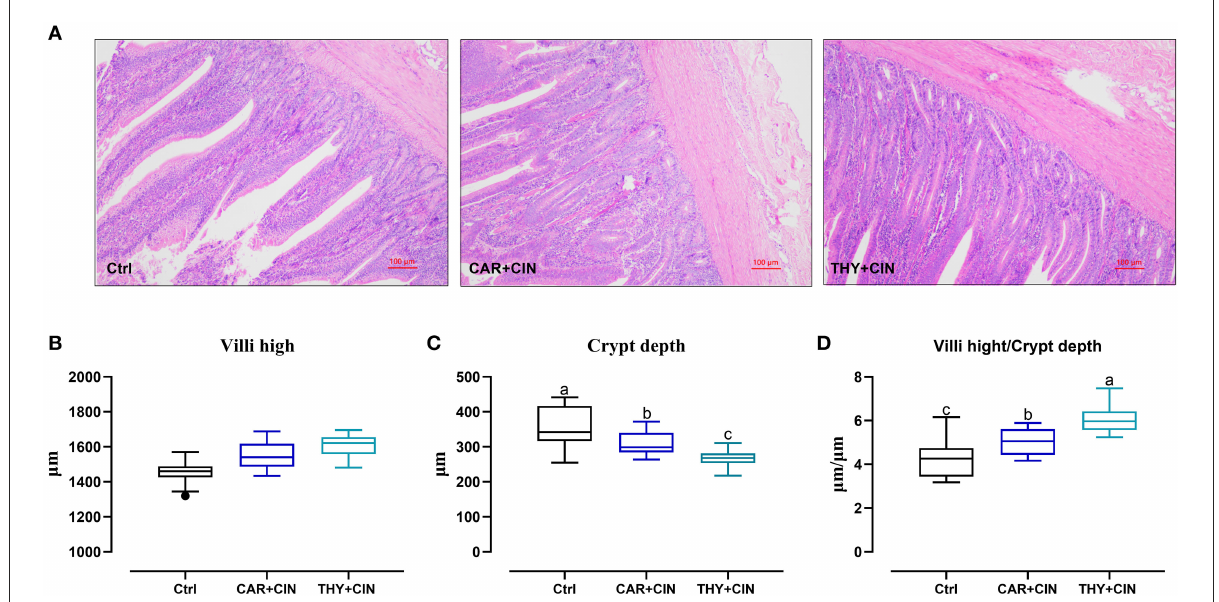
FIGURE2 The effects of dietary cinnamaldehyde with carvacrol (CAR + CIN) or thymol (THY + CIN) essential oils on the duodenal structure of post-peak laying hens. (A) Representative hematoxylin/eosin staining of the duodenum and (B) villus height. (C) Crypt depth. (D) The ratio of villus high to crypt depth were measured in the duodenum. Scale bar = 100 µ m. Boxes are bounded by the 25th and 75th percentiles with the median shown by the line bisecting the box in the box-whiskers plot. Whiskers extend to the full range of the data. Outliers are represented by dots. Means without a common letter are significantly different ( P < 0.05). In this study, a total of 384 50-week-old Hy-line brown laying hens were randomly divided into a basal diet (Ctrl), a basal diet with 100 mg/kg of essential oils consisting of 4.5% cinnamaldehyde with 13.5% of carvacrol (CAR + CIN), and a basal diet containing 100 mg/kg of essential oils composed of 4.5% of cinnamaldehyde with 13.5% of thymol (THY + CIN) for 6